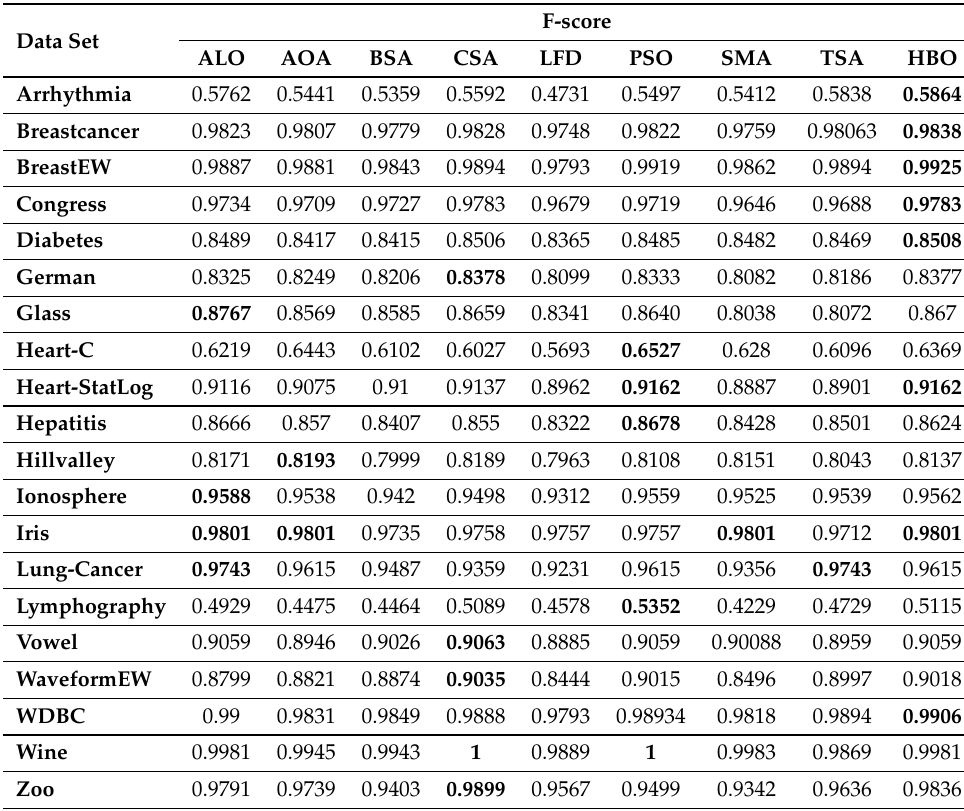
Table 8. The average test F − score of B_HBO against other recent optimizers.